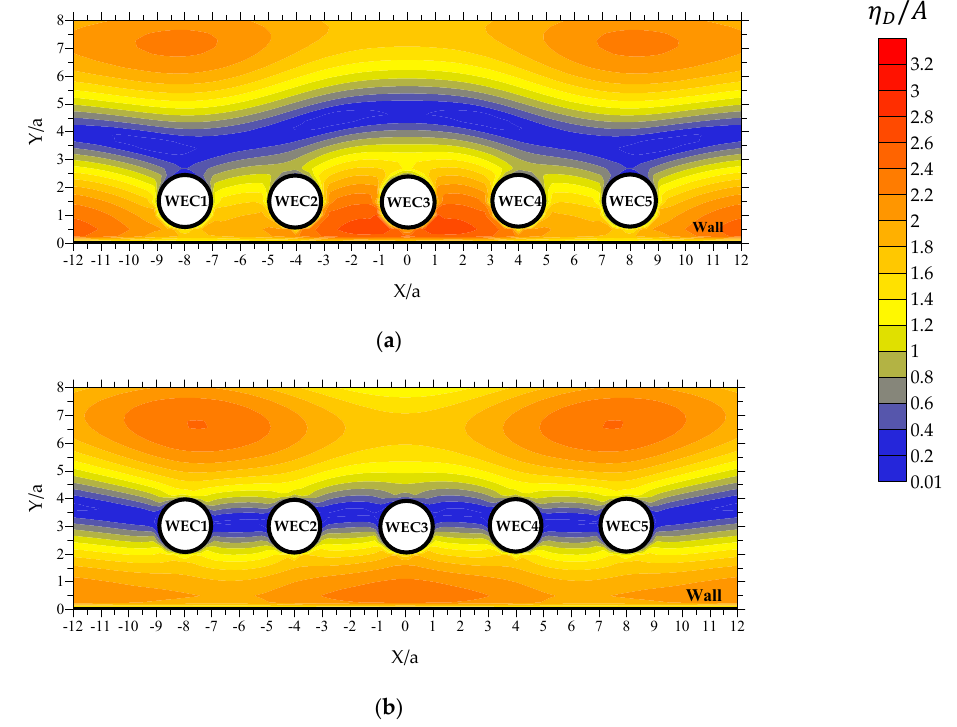
Figure 13. Spatial variation of η D / A at ω = 1.5 rad / s for the array with semi-immersed oblate spheroidal WECs ( 𝑙 (cid:3050) /𝑎 = 36 and 𝑙 (cid:3029)(cid:3032)(cid:3047) /𝑎 = 4 ): ( a ) 𝑐/𝑎 = 1.5 and ( b ) 𝑐/𝑎 = 3.0 . In the case of 𝜔 = 2.3 rad/s, the consideration of incident waves with shorter wave length seaward side of the boundary (Figure 15b), where 𝜂 (cid:3005) /𝛢 has almost zero values. The first zone (coined hereafter “zone B1”) is bounded at approximately 1.0 ≤ 𝑌/𝑎 ≤ 2.0 , while the second and